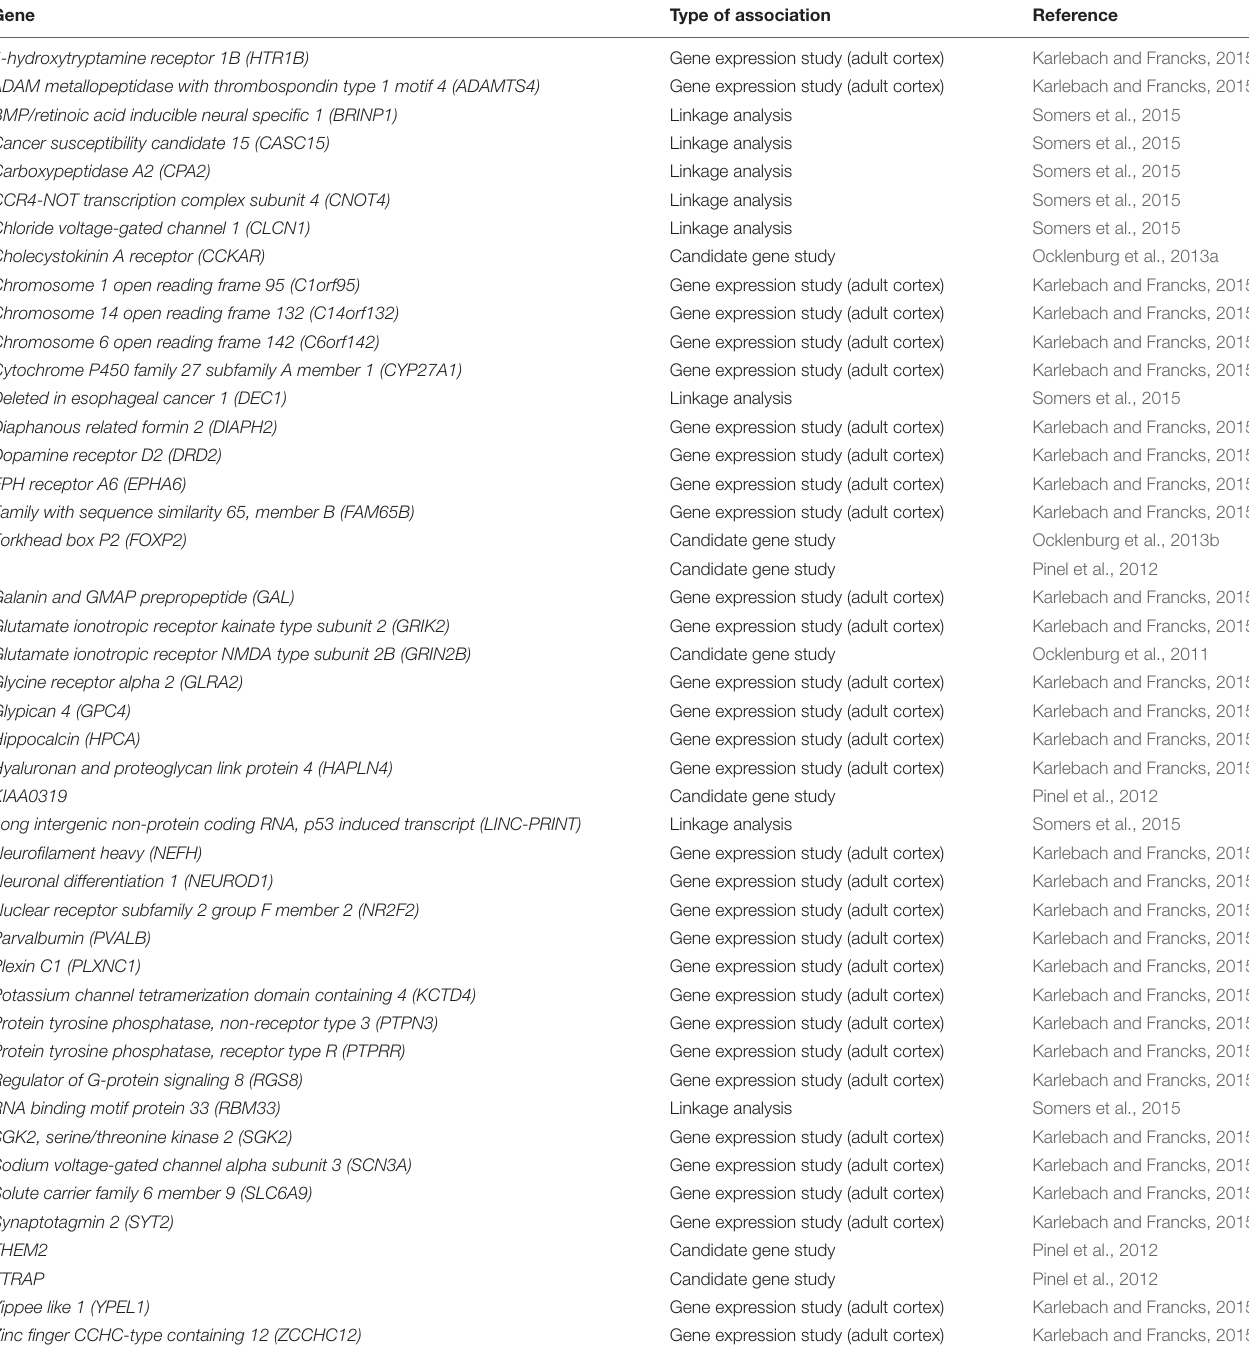
TABLE 2 | Identified genes involved in the ontogenesis of language